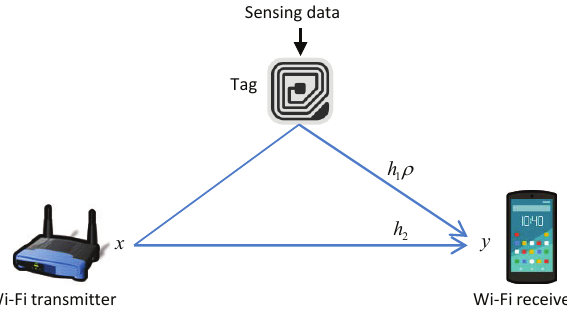
Figure 1. System model of Wi-Fi backscatter